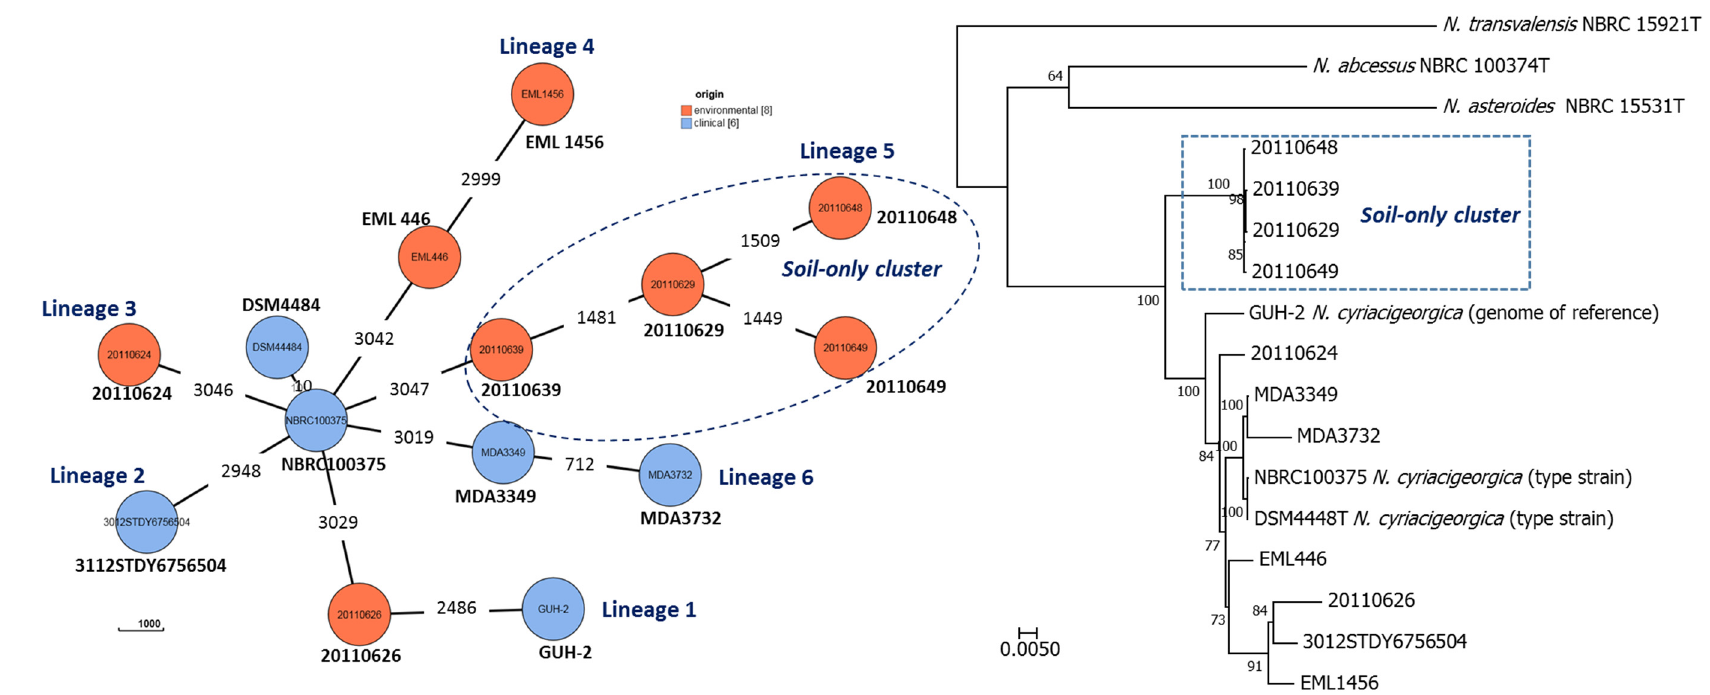
Figure 5. Left: Phylogenetic tree constructed by MAFFT alignment and neighbor-joining with the Clustal W2 algorithm, based on the cgMLST associations among the N. cyriacigeorgica genomes. The tree was built using chewBBACA software and based on 3048 loci. [40]. The DSM 44484T and NBRC 100375 genomes correspond to the N. cyriacigeorgica type strain IMMIB D ‐ 1627; GUH ‐ 2 is the reference genome. Branches indicate the number of different alleles. Right: maximum likelihood phylogenetic tree produced with a concatenated gene matrix with 107 conserved proteins using RAxML v. 8.2.9 and bcgTree software v.1.1.0 software (100 bootstrap replications) [41]. The N. cyriacigeorgica soil strains are colored blue and the Nocardia clinical strains red. The percentage of bootstrap replicate trees (1000 replications) in which the associated taxa clustered together are shown next to the branches. Bar: 0.02 changes per nucleotide position.